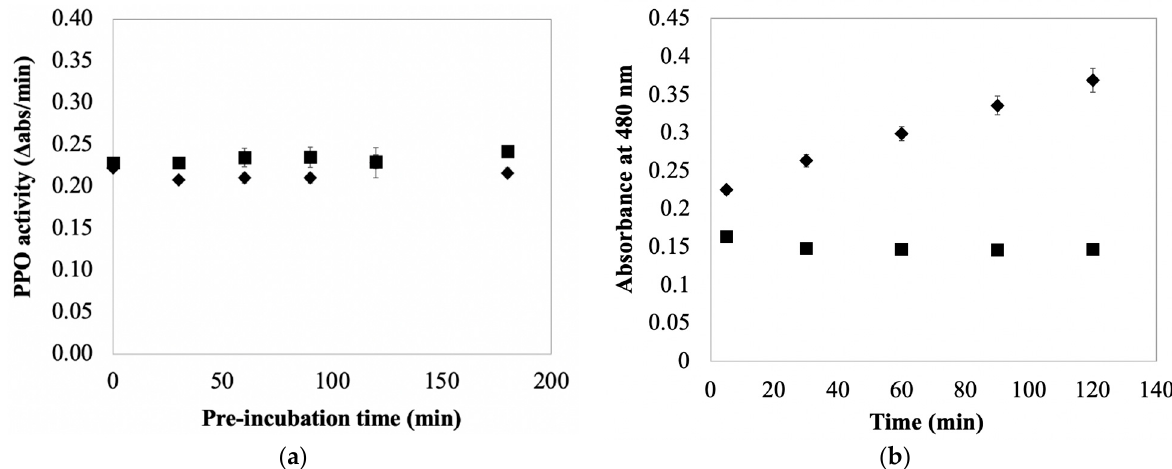
Figure 3. ( a ) Effect of pre-incubating AA with PPOE on subsequent PPO activity measurements using CA as a substrate. PPOE was pre-incubated with ( ■ ) and without ( ◆ ) AA (AA at 4 mM when present) in 50 mM sodium phosphate buffer, pH 7.0, for different periods of time prior to initiating activity measurements by mixing 0.2 mL pre-incubation mixture (containing PPOE and AA) with 2 mL buffered CA solutions (final concentration 1 mM CA). Control experiments were treated identically, but without AA. ( b ) Time course of color development in potato extract, depicted as an increase in absorbance, in the absence ( ◆ ) and presence ( ■ ) of AA. Potato extracts were made in 50 mM sodium phosphate buffer containing 0 or 30 mM AA. Color was measured at 480 nm after incubation of potato extracts at room temperature for different periods of time. Values are means ± standard deviations from triplicate assays. Data points without visible error bars have standard deviations smaller than the designated symbols.